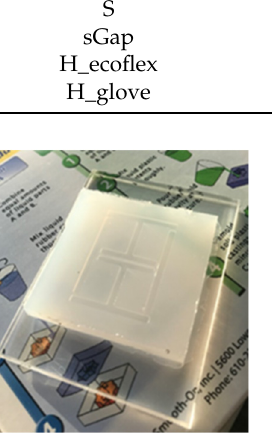
Figure 4. Ecoflex substrate.